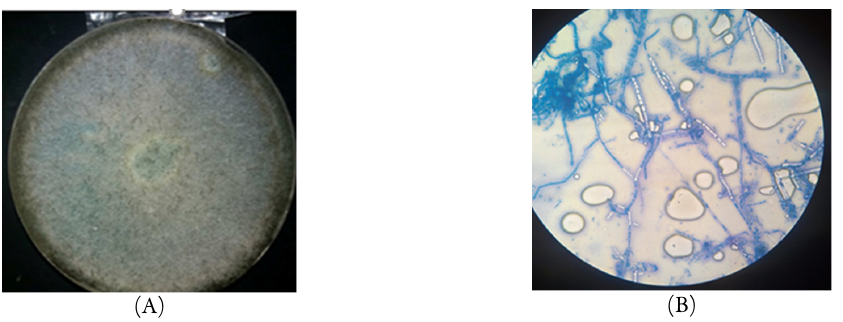
Figure 4. Result of macro and microscopic observation of endophytic isolates ENo; (A)macroscopic